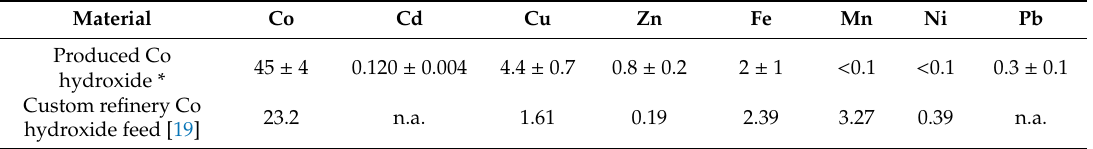
Table 9. Composition (%) of the produced cobalt hydroxide and specifications for the feed of a custom cobalt refinery. Material